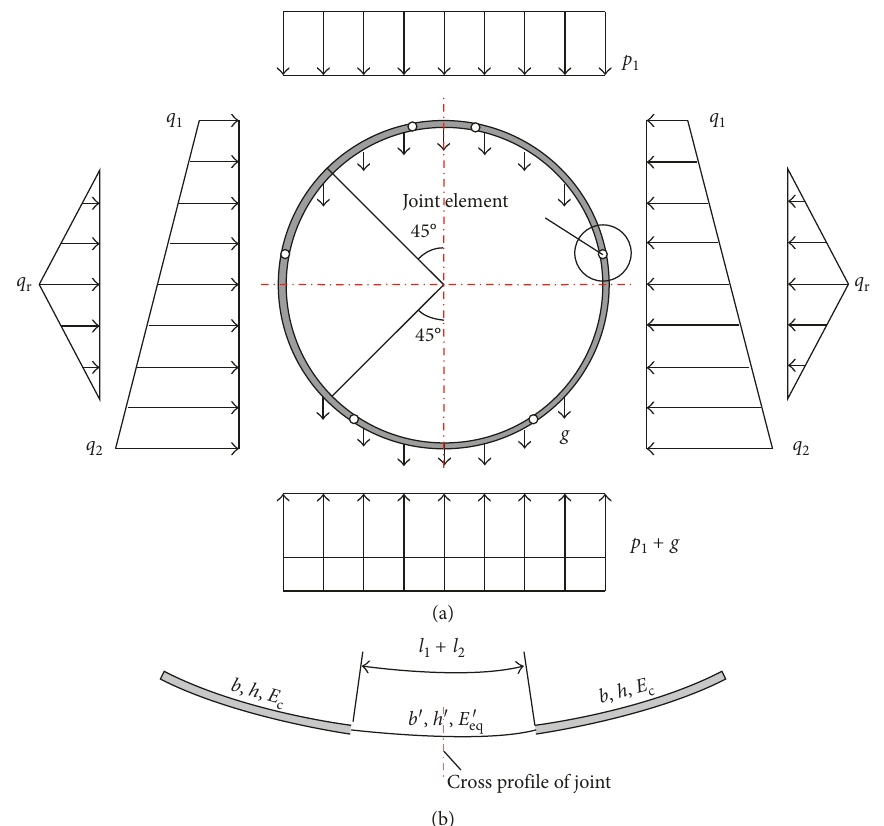
Figure 2: Structural calculation model of shield tunnel segment with HEB model: (a) Structural calculation model; (b) Equivalent beam element of